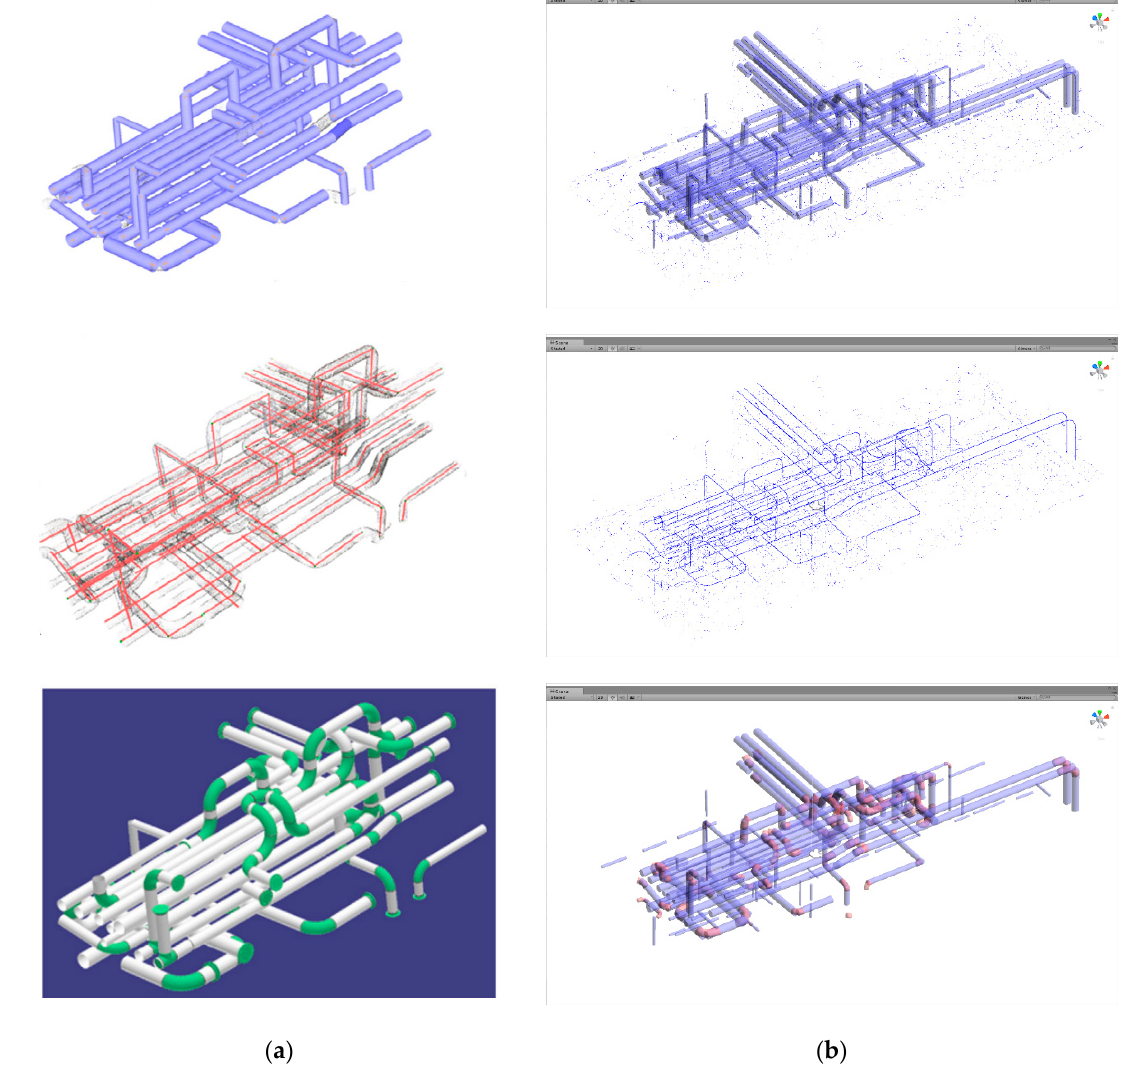
Figure 14. Comparison of proposed method with actual data (right side of Figure 12b). From top to bottom: point cloud/cylinder matching/center axis/final result. ( a ) Estimation by Hough transform [10]; ( b ) estimation by proposed method. Table 2. Comparison verification. C E , actual pipe number; C D , estimated pipe number; C T , estimated success number; C F , estimated failure number; t, run time; Rr, recall rate; Er, error rate; Pr, precision rate.